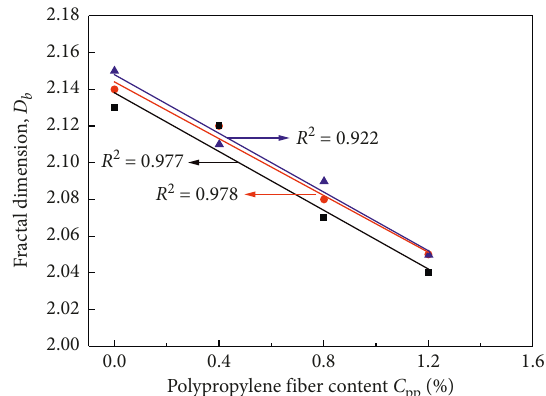
Figure 9: Relationship between fractal dimension and poly- propylene fiber content.